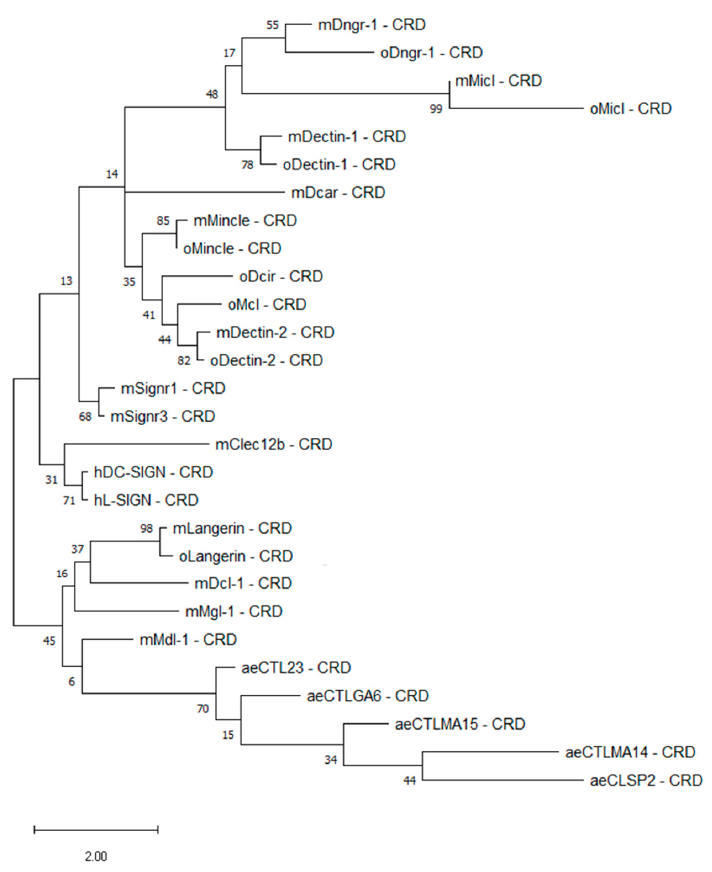
Figure 2. Maximum likelihood phylogenetic analysis of the carbohydrate recognition domain (CRD) of 28 C-type lectin receptors. Amino acid sequences of the respective CRDs were modelled by using bootstrap with 500 replications with the Jones–Taylor–Thornton plus frequency model and a discrete gamma distribution with five rate categories. Percentage frequencies from the bootstrap procedure are shown at each knot. Mosquito amino acid sequences were obtained from VectorBase, while mammalian sequences were from NCBI (Tables 1 and 2). ae: Aedes aegypti , h: Homo sapiens sapiens , m: Mus musculus , o: Ovis aries . Phylogenetic analysis was performed with MEGA Software. Table 1. Primers (fw, forward; rev, reverse) used to amplify the extracellular domain of mosquito C-type lectin domain-containing proteins (CTLDcps) from reference genome AaegL5.1 (VectorBase). Terminal restriction sites are underlined, and primer binding sites are shown in italic. Respective PCR amplicon size in base pairs (bp) and final CLR–hFc fusion protein size (after cleavage of IL-2 signal peptide after Ser20) in kilodaltons (kDa) are